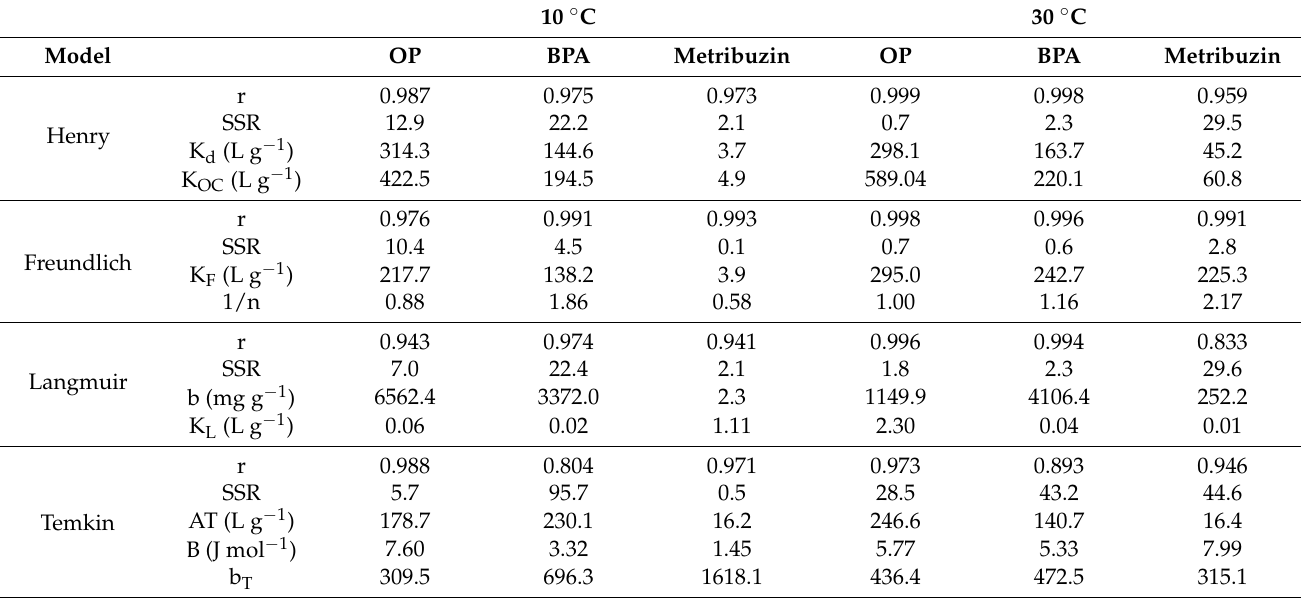
Table 5. Adsorption parameters of the three compounds onto